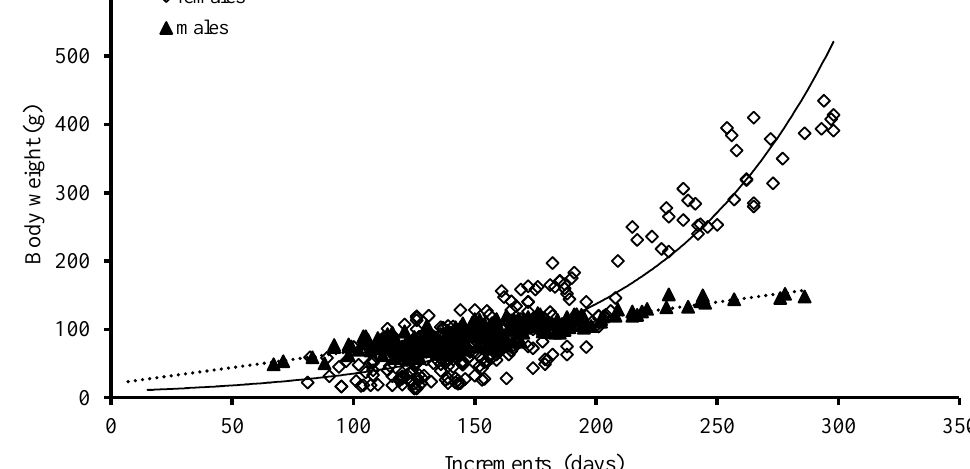
Figure 8. Relationships between body weight (BW) and age for S. oualaniensis in the waters of the Xisha Islands of the South China Sea.